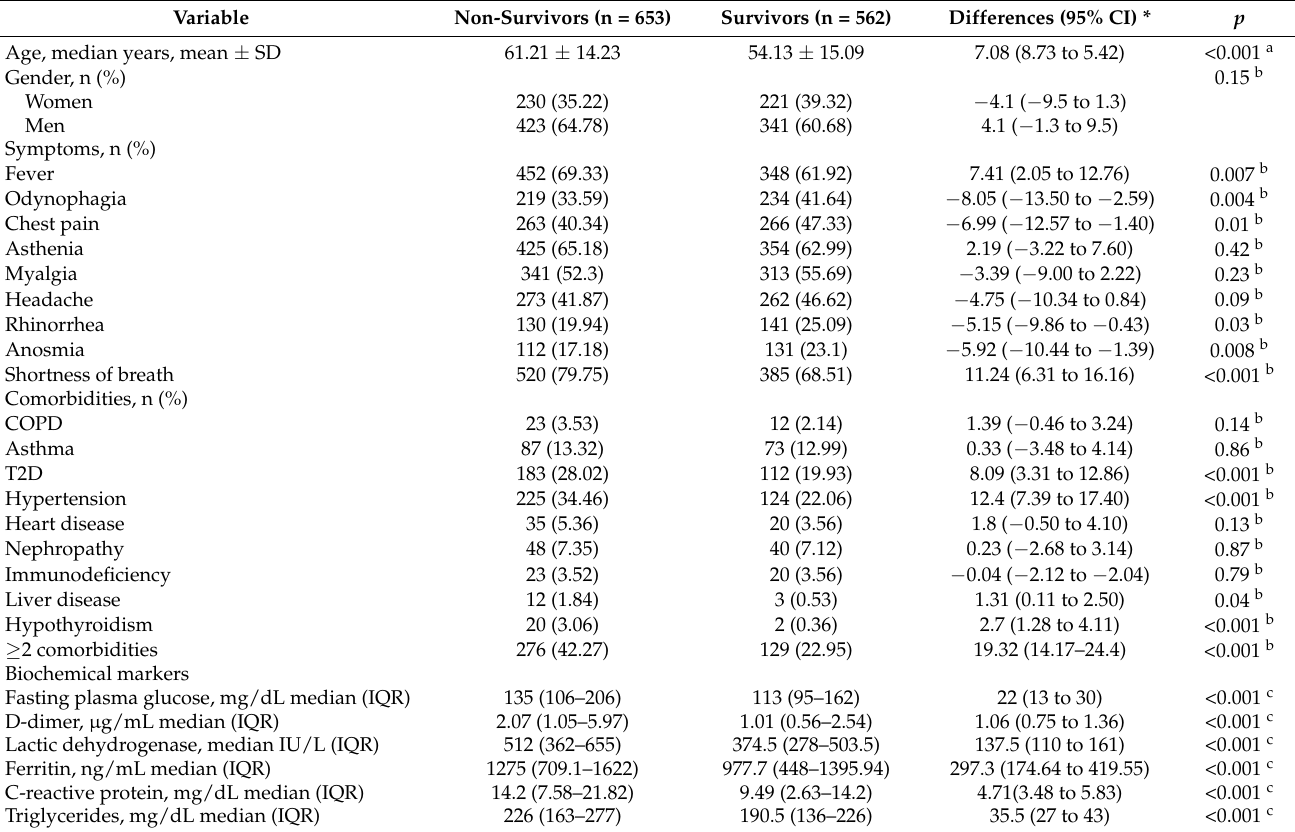
Table 1. Baseline characteristics of 1215 hospitalized patients with a diagnosis of COVID-19.